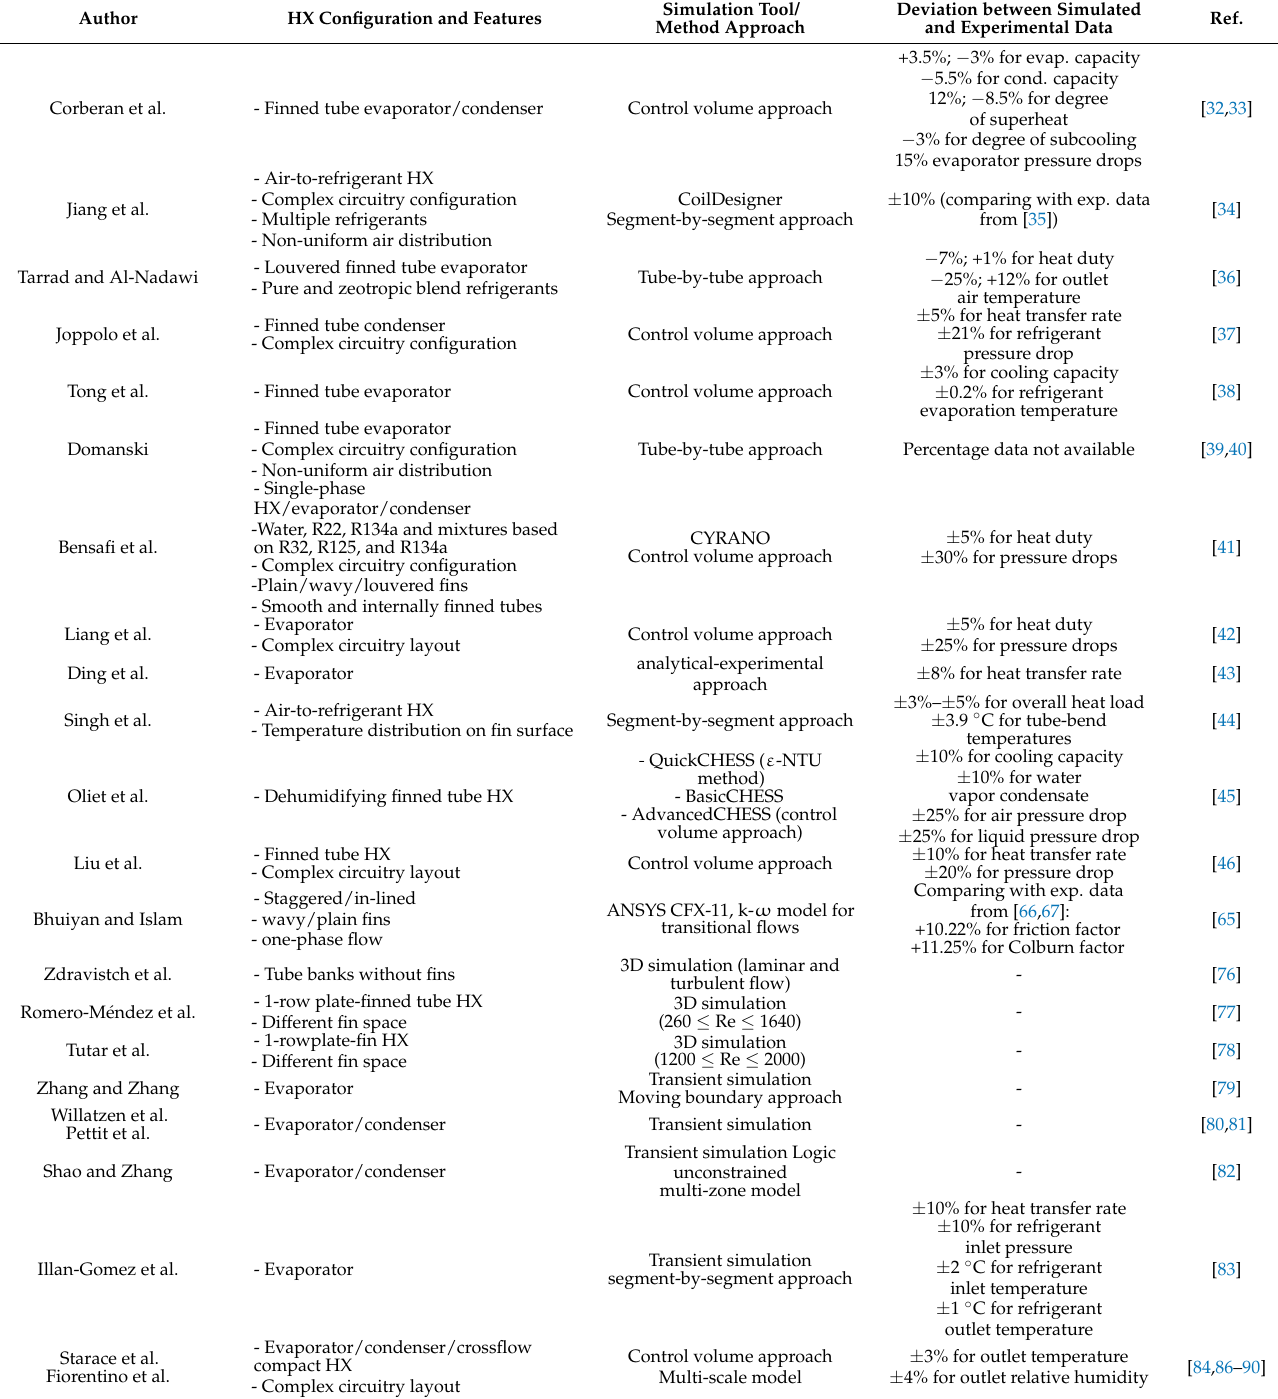
Table 3. A selection of finned tube modelling